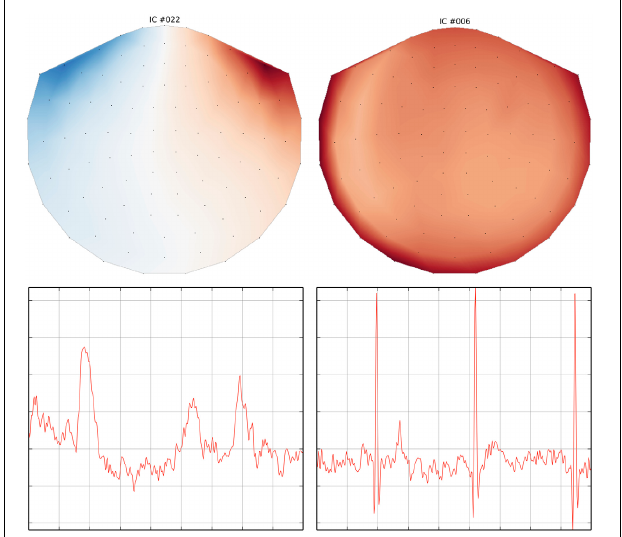
FIGURE 6 | Topographic and trellis plots of two automatically identified ICA components. The component #22 corresponds to the EOG artifact with a topography on the magnetometers showing frontal signals and a waveform typical of an eye blink. The component #6 on the right captures the ECG artifact with a waveform matching 3 heart